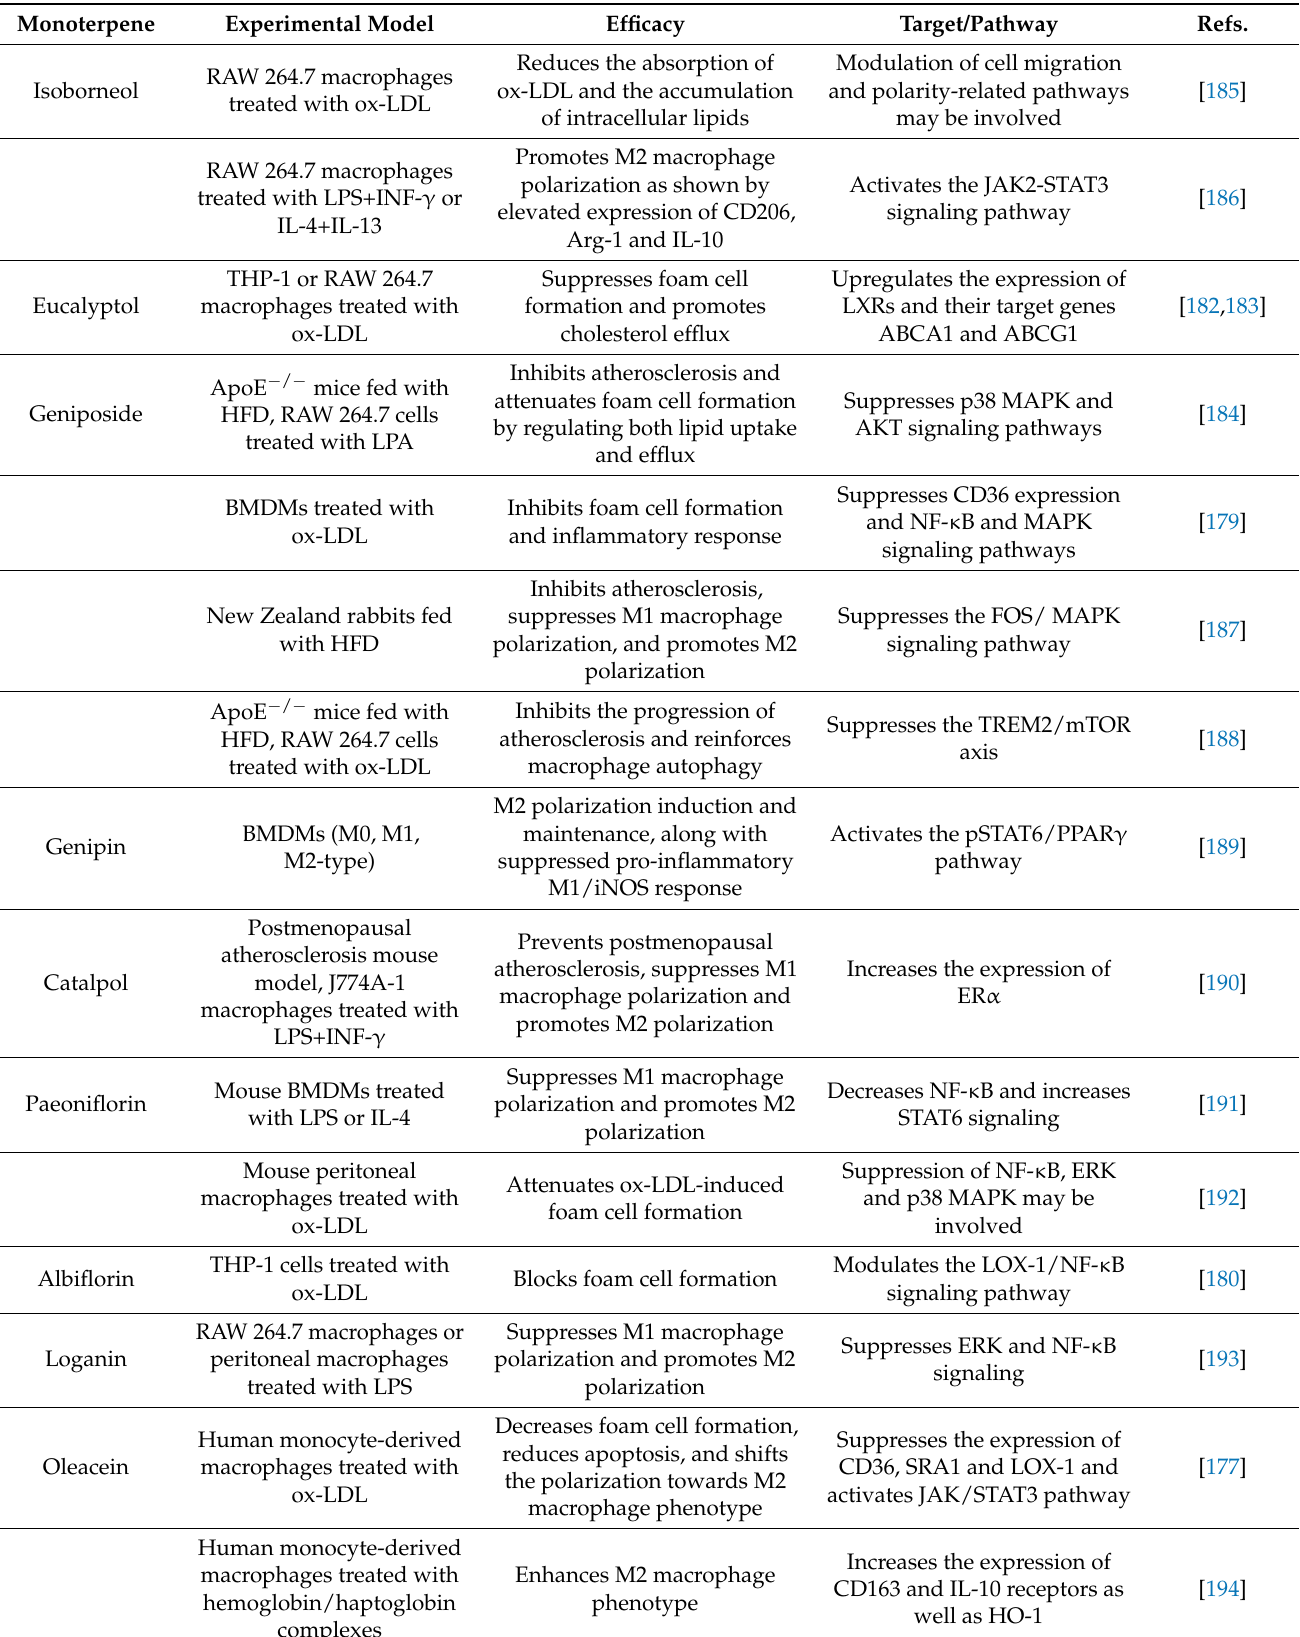
Table 6. Modulation of foam cell formation, autophagy and M2 macrophage